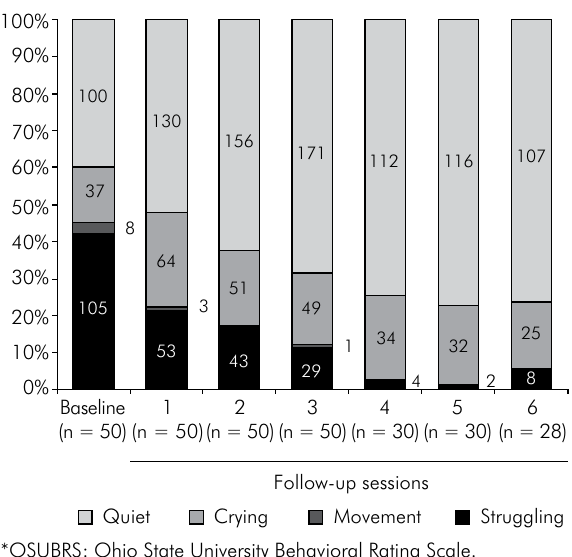
Figure 1. Relative and absolute frequencies of OSUBRS* scores obtained during the different follow-up sessions representing the highest behavioral score observed at 5 key intervals.